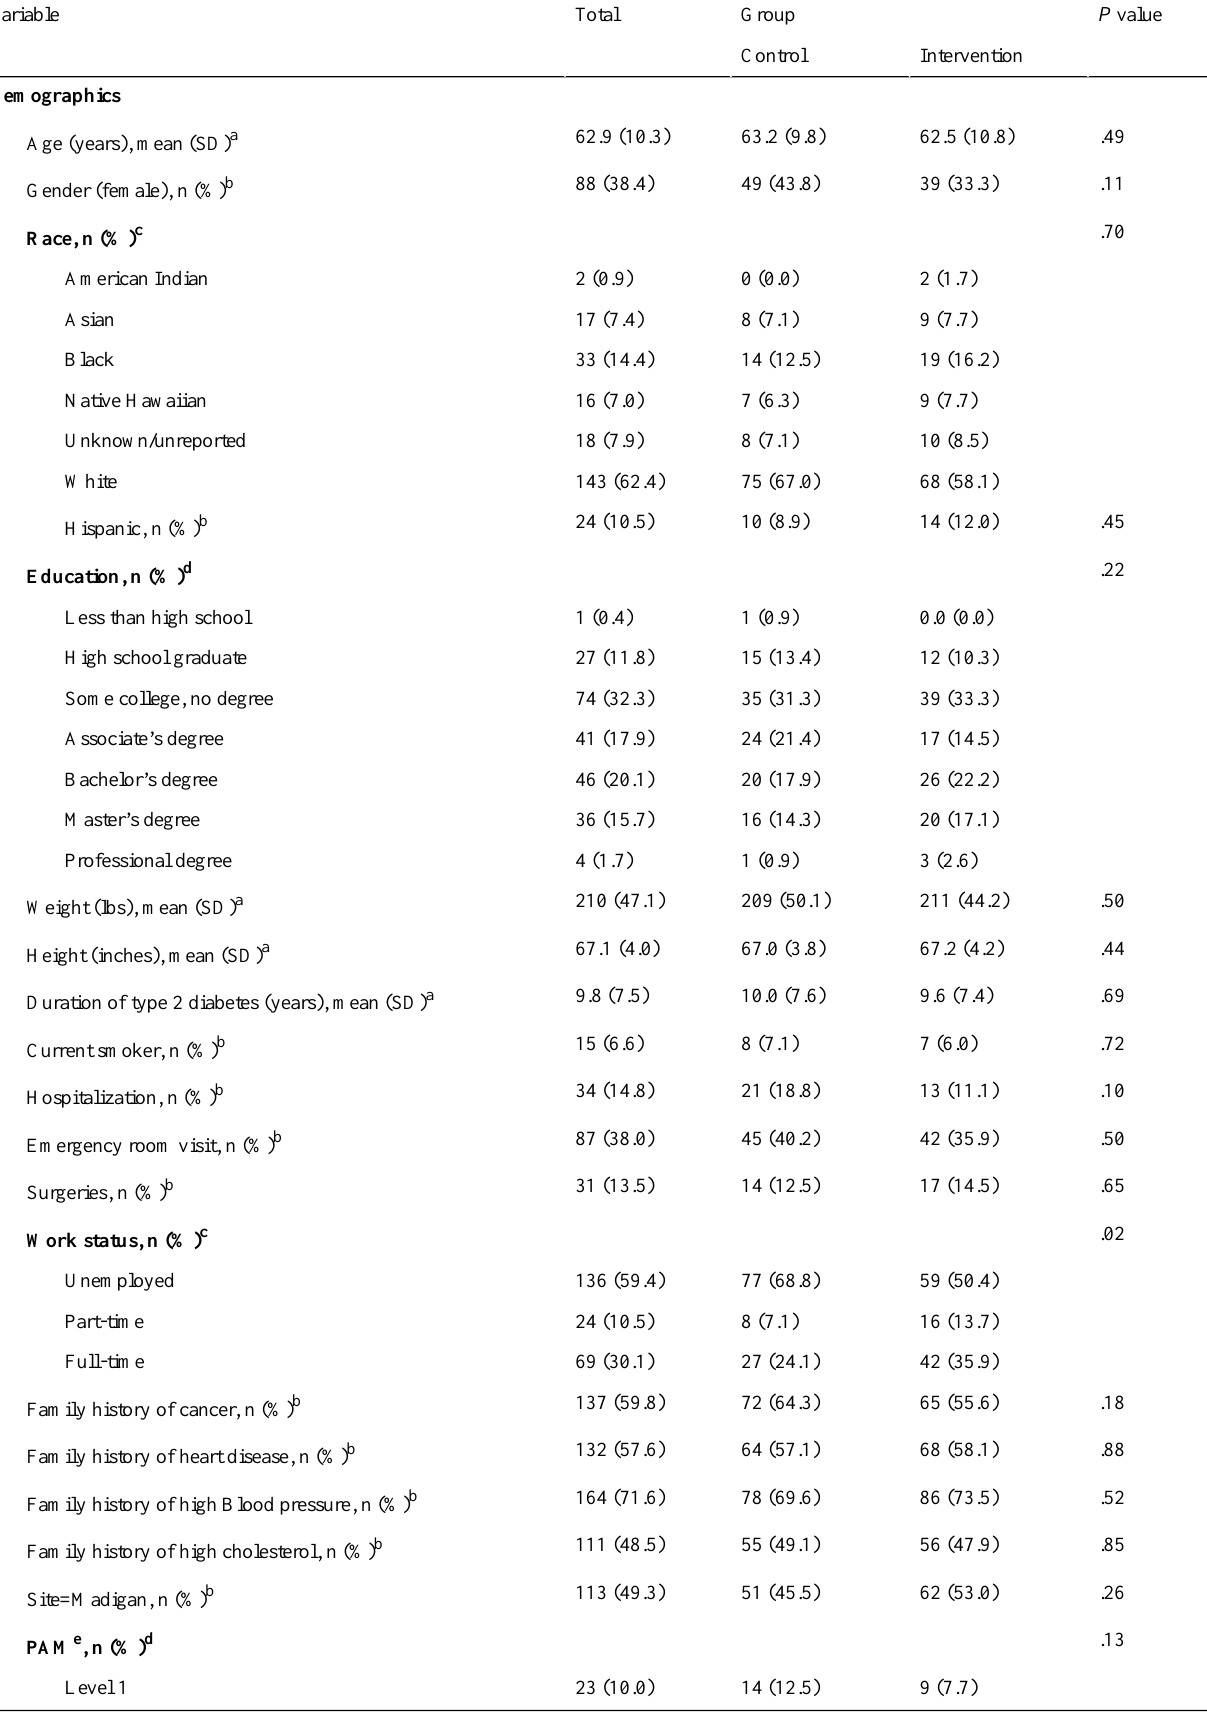
Table 3. Characteristics of phase II participant demographics and outcomes at baseline.